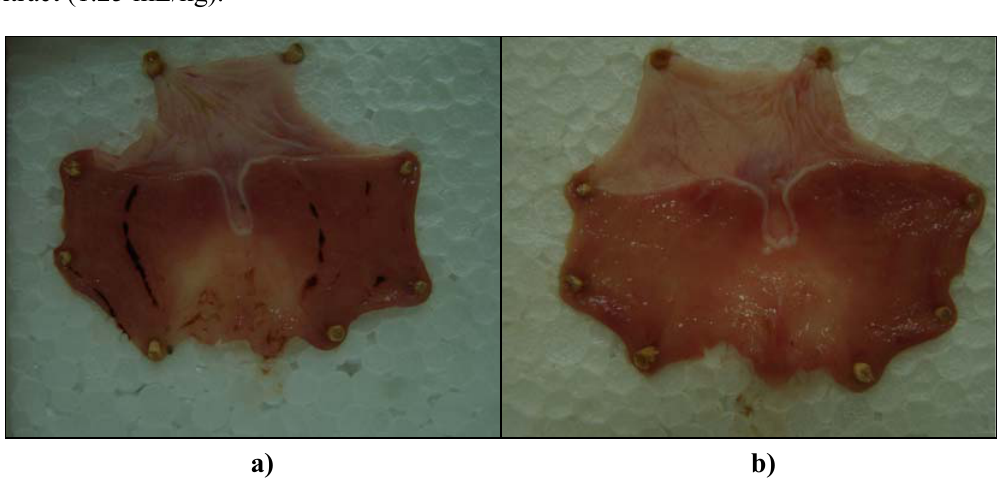
Figure 3. Representative rats' stomachs after cold restraint stress (a) control rat receiving sunflower oil (1.25 mL/kg) and (b) rat pretreated with St. John’s Wort olive oil extract (1.25 mL/kg).